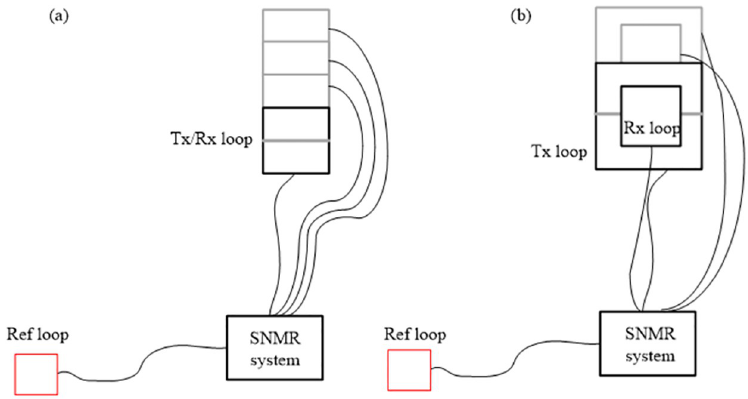
Fig 2. SNMR field setup. (A) Coincident loop configuration. (B) Separated loop layouts. The shapes and sizes of the transmission and reception loops can be different and one can arrange them in different ways. In general, the size and shape of the reference loop are set to be the same as those of the transmission/reception